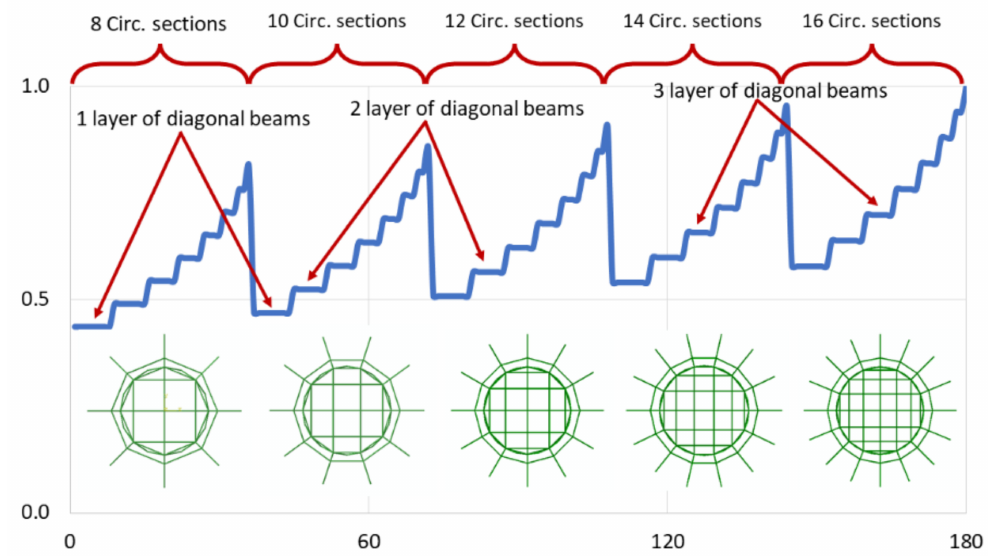
Figure 9. Volume fraction of all structures in the design space. The plan view of the helideck structures is shown below the volume fraction